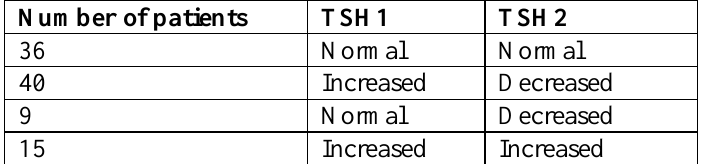
Table3: shows TSH status after metformin in the total 100 patients. TSH1 indicates initial TSH, TSH 2 indicates TSH level after therapy with metformin.